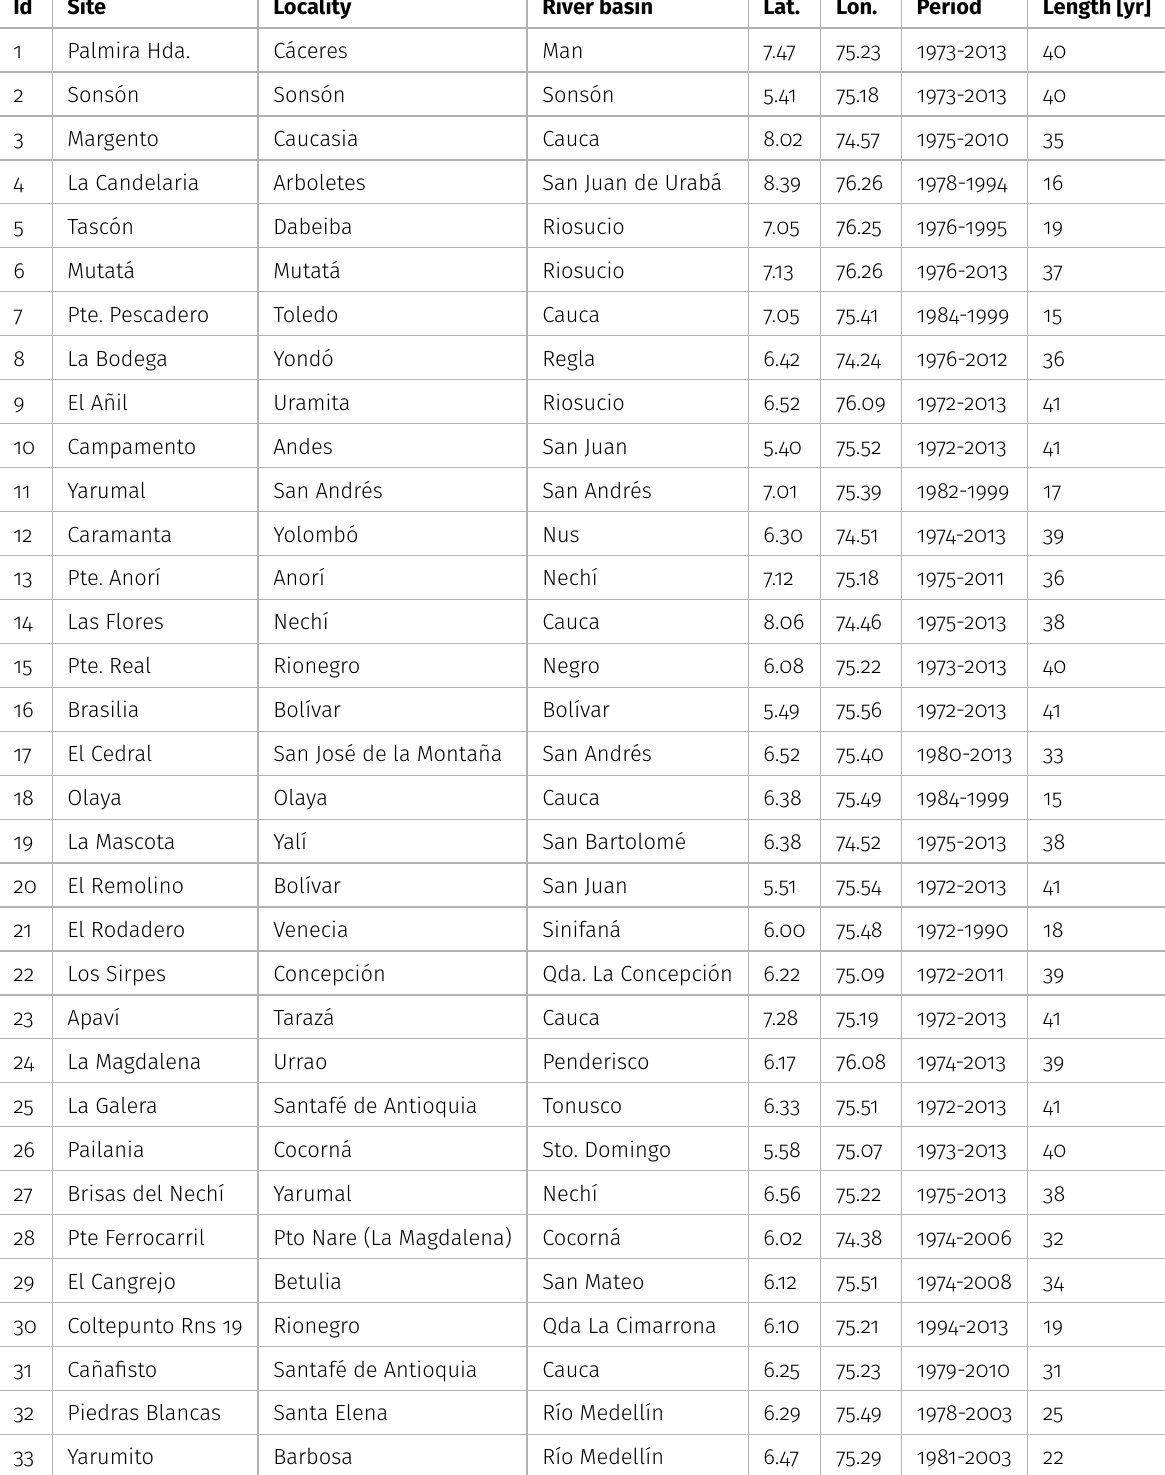
Table I. General characteristics of discharge measurement stations in state of Antioquia-Colombia. Sites 1–31 belong to IDEAM and sites 32–33 to